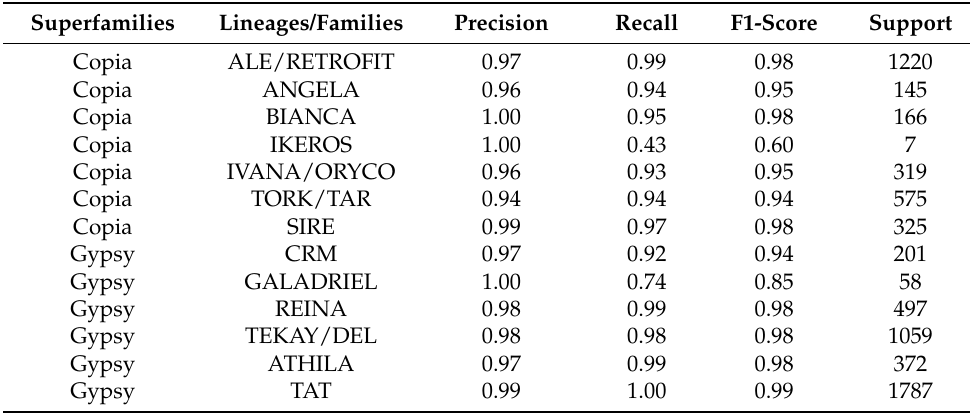
Table 5. Performance obtained for each lineage using the CNN architecture. Superfamilies Lineages/Families Precision